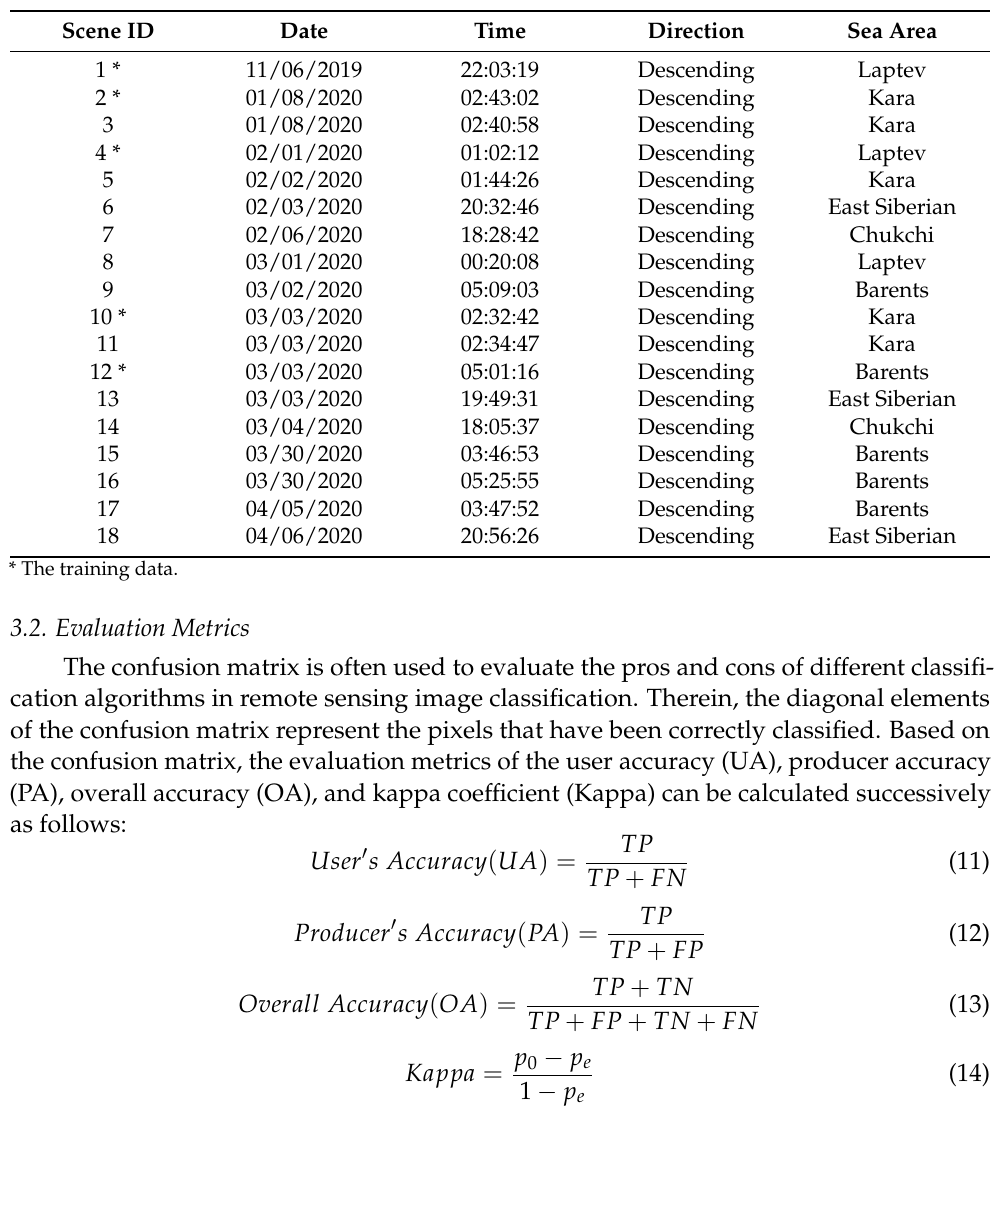
Figure 7. The study area of this study. ( a ) The Northeast Passage. ( b ) Image footprints of 18 Sentinel-1 scenes. Table 2. Information of 18 scenes of Sentinel-1 EW SAR sea ice images.